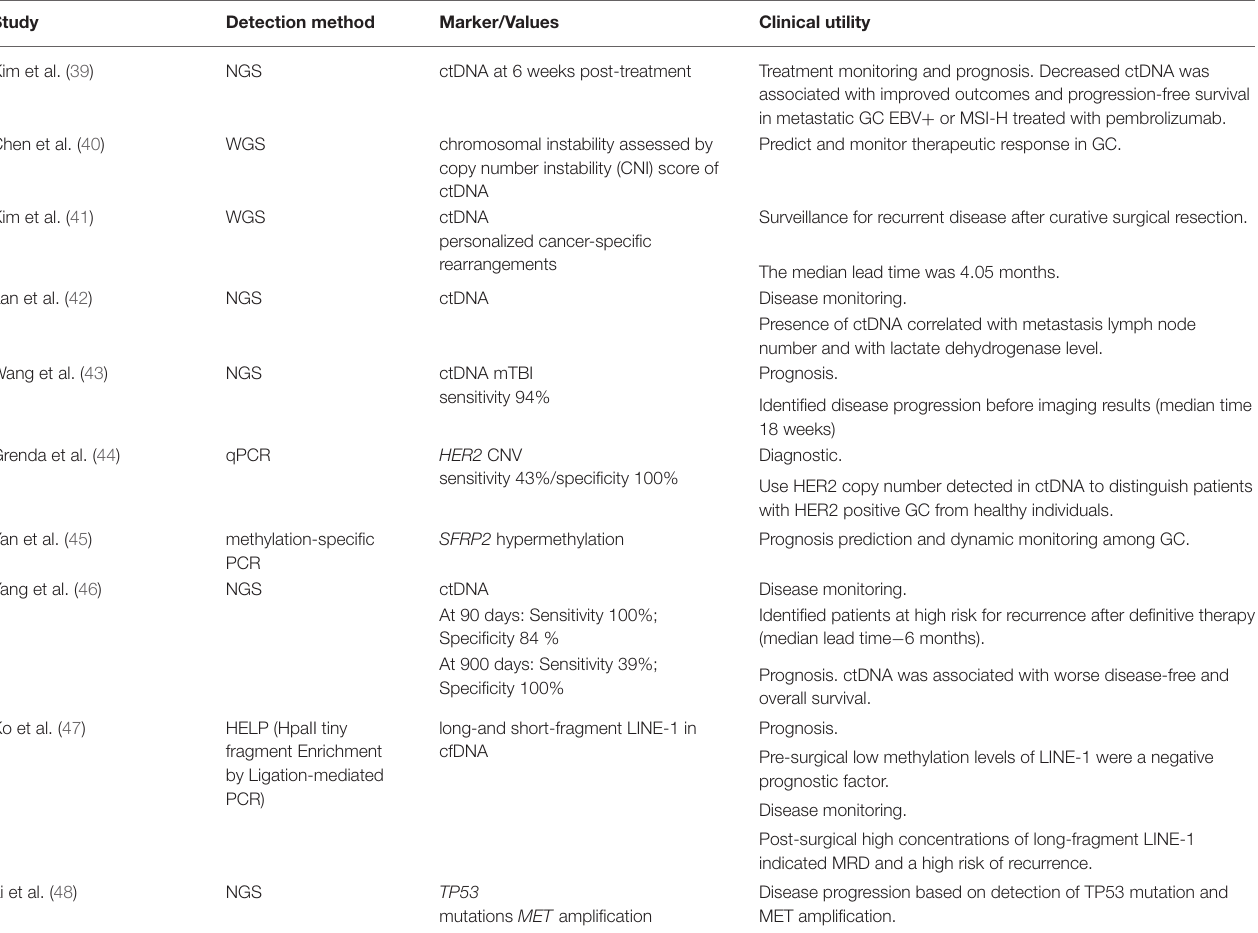
TABLE 2 | ctDNA as biomarker in GC.